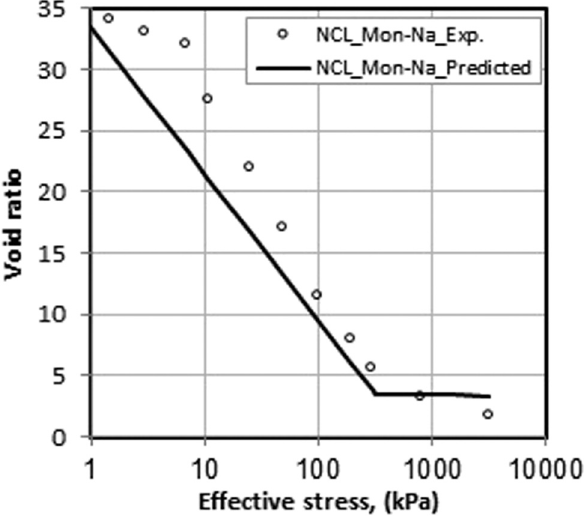
Figure 16: The experimental data and the predicted results of the one - dimensional consolidation tests for the Mon - Na soil ( experi - mental data from [ 36 ])